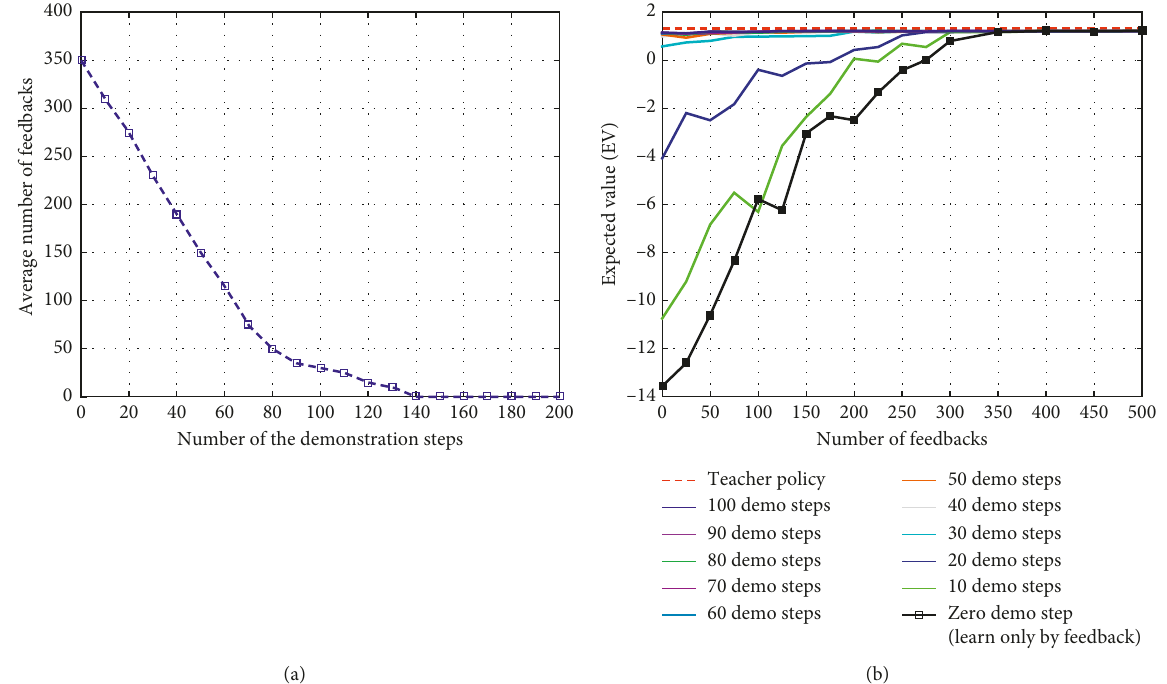
Figure 6: (a) The relation between sparsity level of demonstrations in stage-one and the number of feedbacks needed to reach “EV” score equal to 1.17 using IRLDC. (b)IRLDC’s stage-two performance in face of optimal and different demonstration sparsity levels in stage-one (point “B1”, ... , “B10” in Figure 3) and the number of evaluative feedbacks. The black curve has no initial demonstration (point “C” in Figure 3).